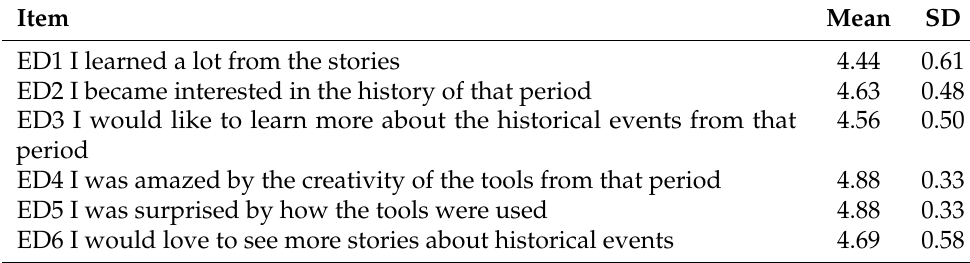
Table 1. Questions are split according to evaluation construct—EDx for Edutainment, IMx for Immersion, and EEx for Effort Expectancy. Responses were delivered on a 5-point Likert scale, with 1 = strongly disagree and 5 = strongly agree. Respective summary statistics are shown: Mean and Standard Deviation (SD). *: Questions EE2 and EE6 represent negative attitudes, hence the responses were complemented prior to